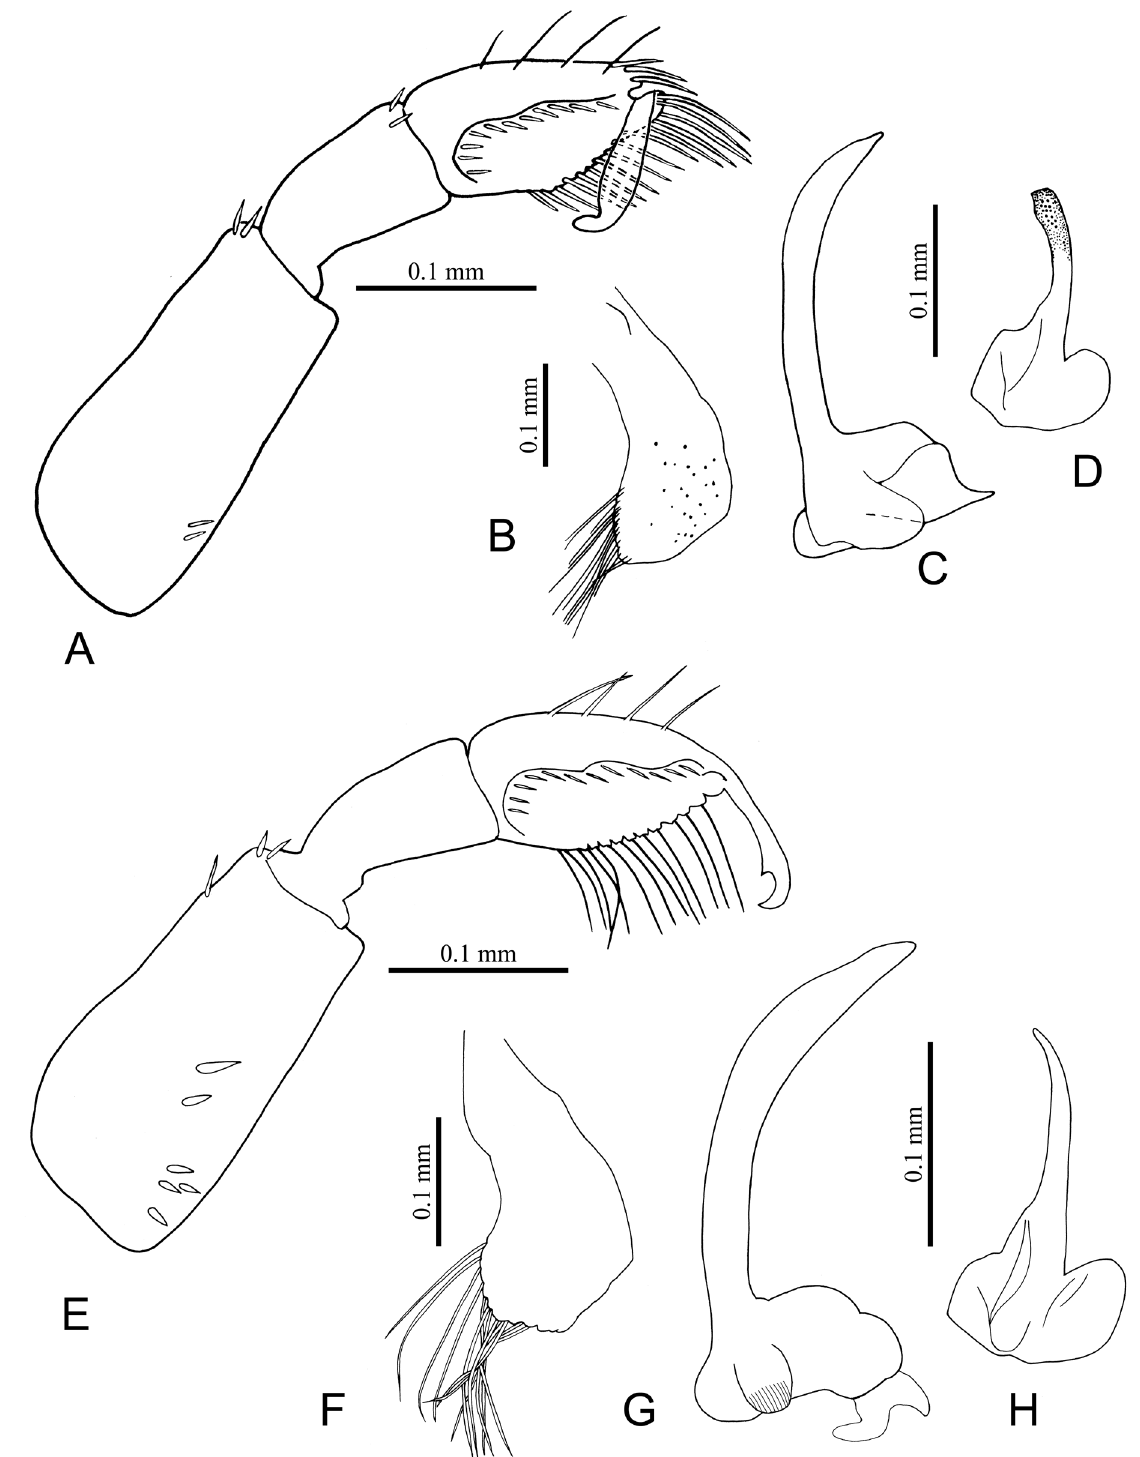
Fig. 25. Morphological features of species of Micronecta Kirkaldy, 1897, ♂♂. A–D . M. fugitans Breddin, 1905 (ZVNU). E–H . M. tarsalis Chen, 1960 (ZVNU). A, E = fore leg; B, F = free lobe; C, G = right paramere; D, H = left